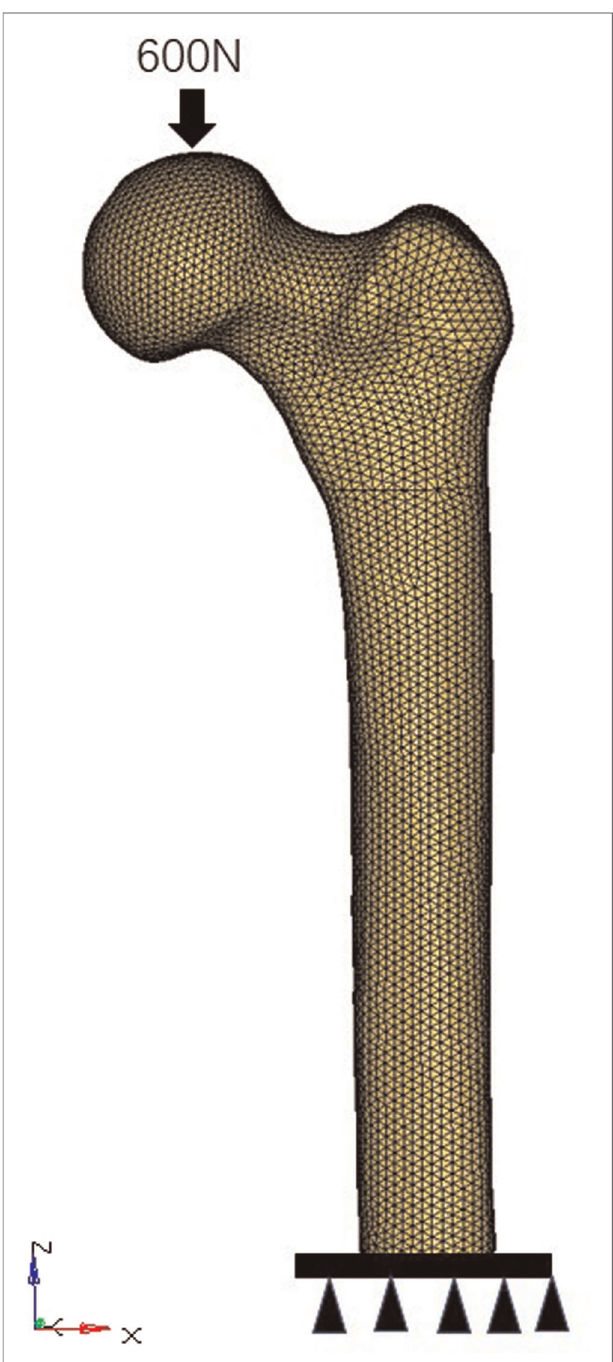
FIGURE 3 | Boundary conditions of the